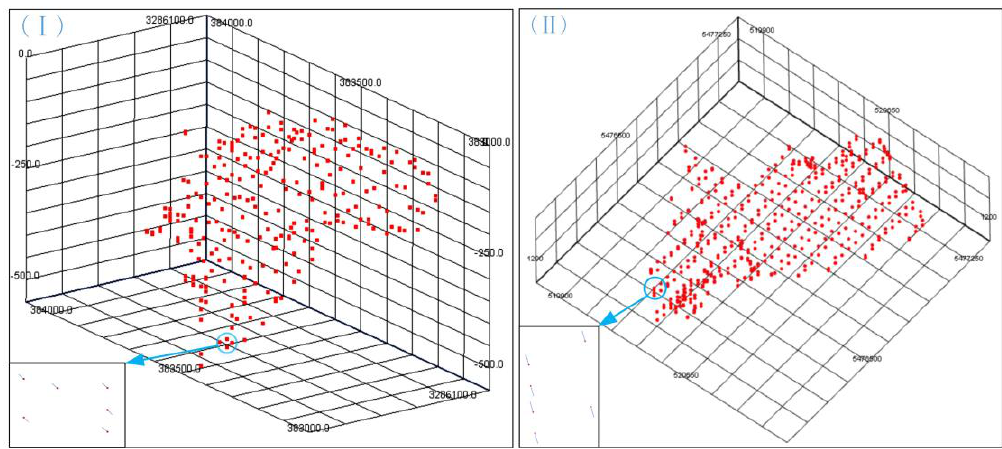
Figure 7. Point Cloud and Point-Cloud Normal Direction for Case I and Case II.